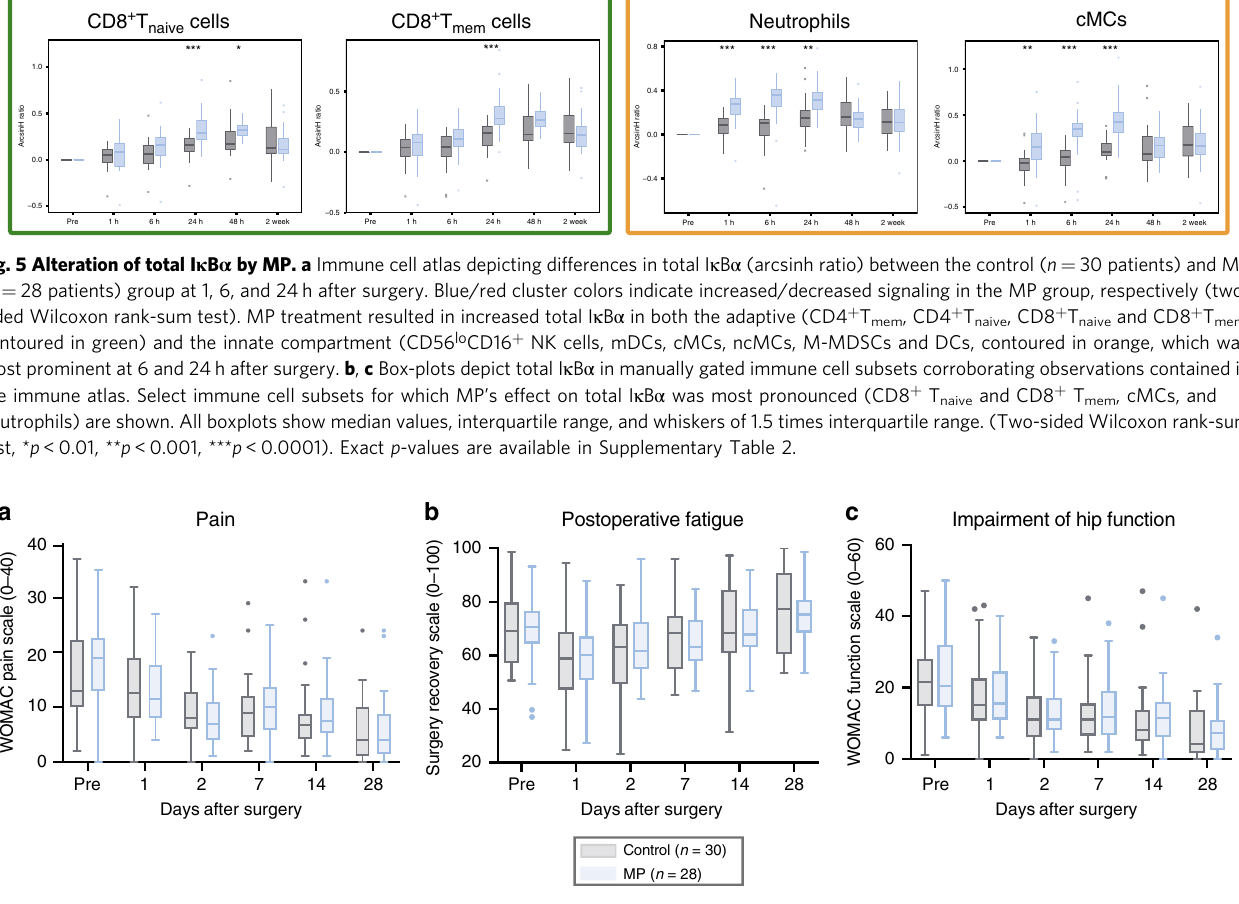
Fig. 6 Clinical recovery outcome measures between control and MP treatment. All boxplots show median values, interquartile range, whiskers of 1.5 times interquartile range of clinical recovery parameters ( a ) pain, ( b ) fatigue and daily functioning, and ( c ) functional impairment of the operated hip over the course of 28 days after surgery between control ( n = 30 patients) and MP ( n = 28 patients) groups (two-sided Wilcoxon rank sum test). Pain and functional impairment of the hip were assessed with an adapted version of the Western Ontario and McMaster Universities Arthritis Index (pain 0 to 40 = none to worst; function 0 to 60 = no to most severe impairment). Postoperative fatigue and daily functioning were assessed with the Surgical Recovery Scale (17 to 100 = worst to